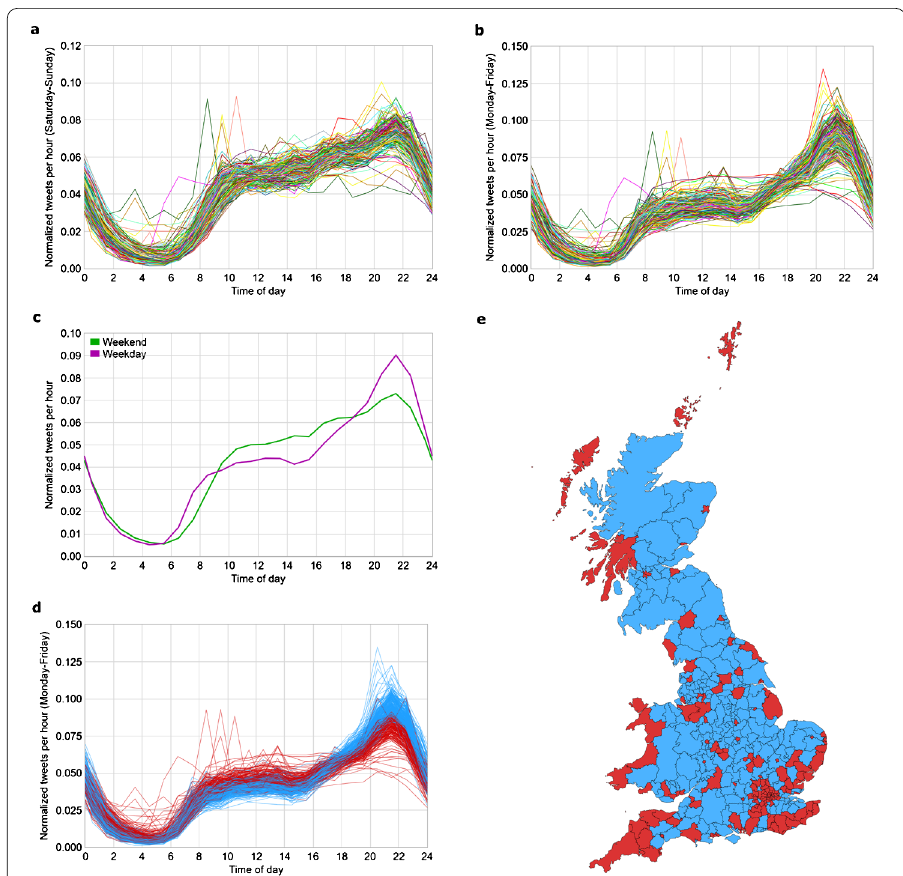
Figure 4 Temporal distribution of tweets for each local authority. (a) Saturday and Sunday. (b) Monday-Friday. (c) Mean of weekend and weekday distributions. (d) Clustering local authorities on Monday-Friday distributions using K -medioids ( K = 2) with the earth-mover’s distance. (e) Cluster membership of local